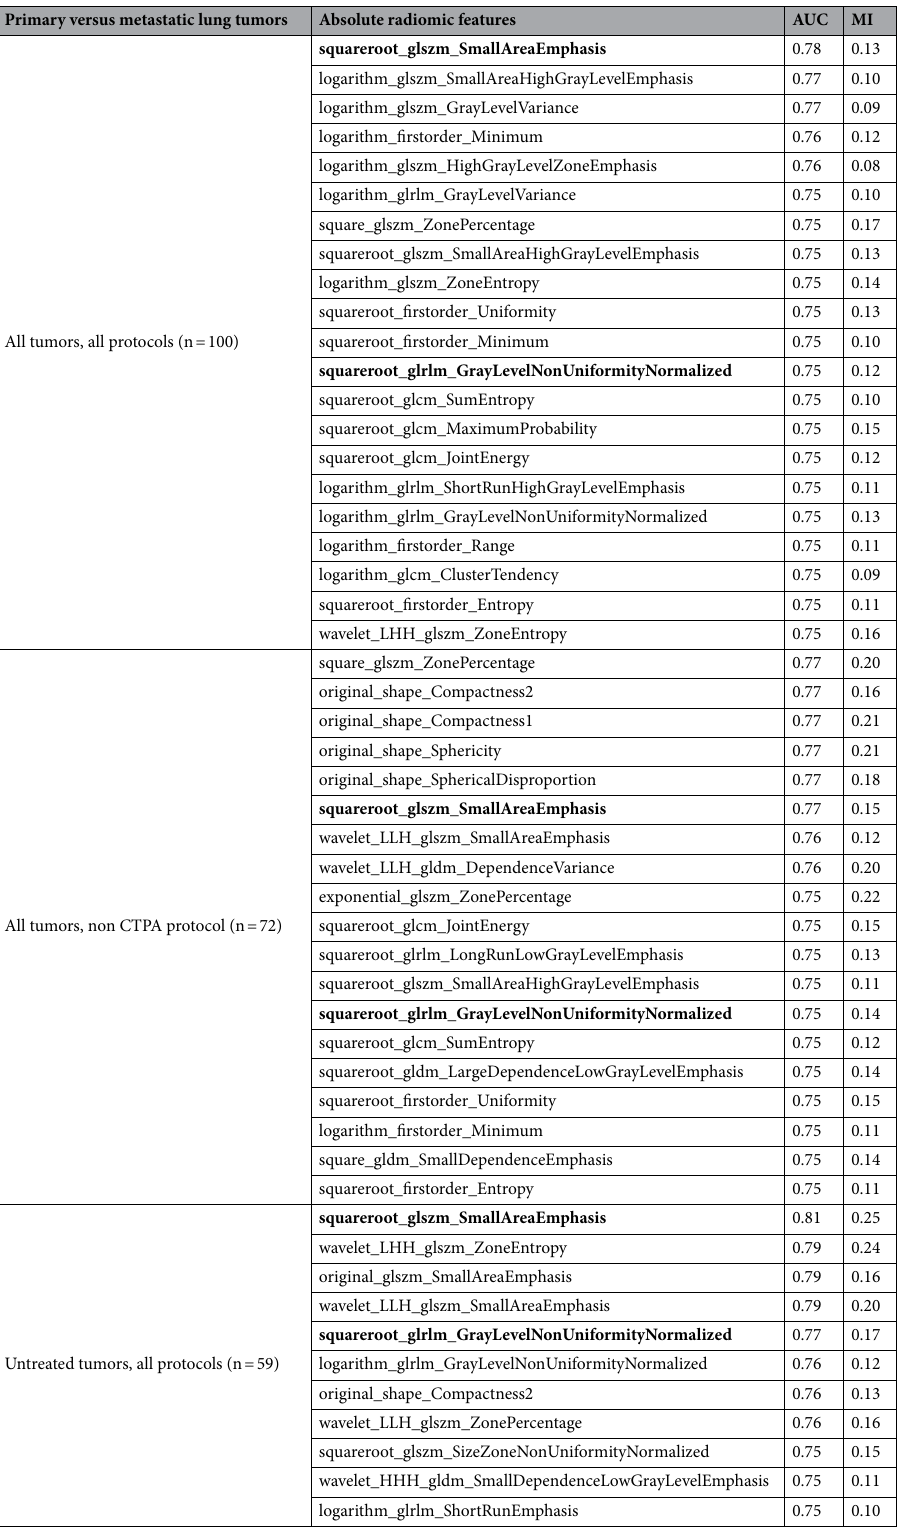
Table 3. Significant radiomic features in distinguishing primary versus metastatic pulmonary tumors with individual AUCROC ≥ 0.75. MI mutual information